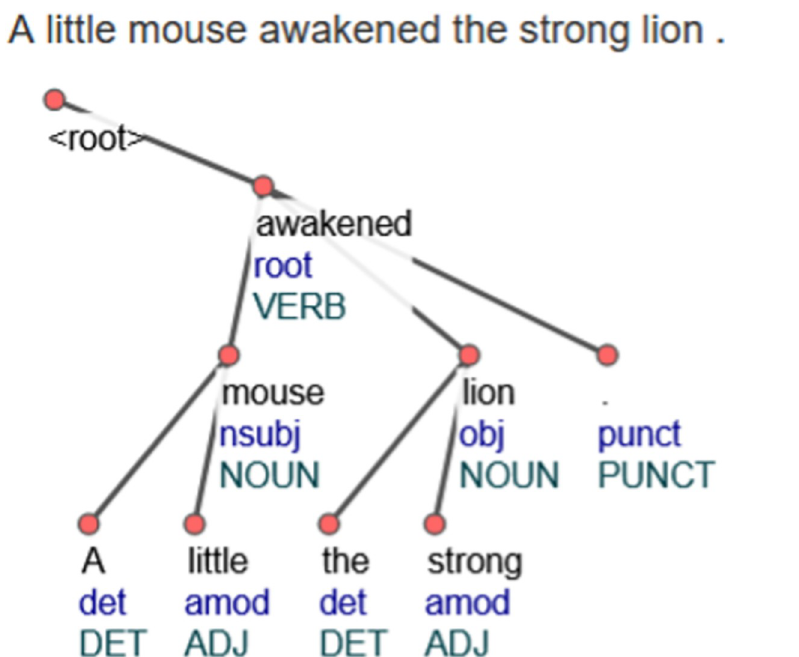
Fig 1. Graphical representation of the dependency of terms in a sentence.